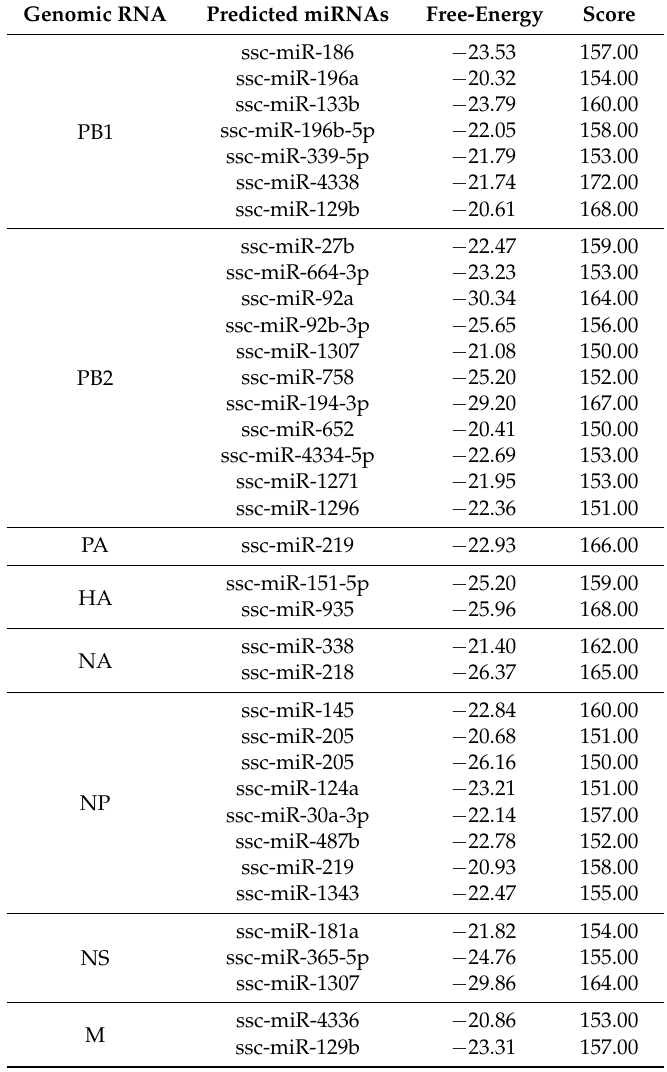
Table 2. Potential miRNAs targeting the genomic RNA of H5N1 influenza A virus predicted